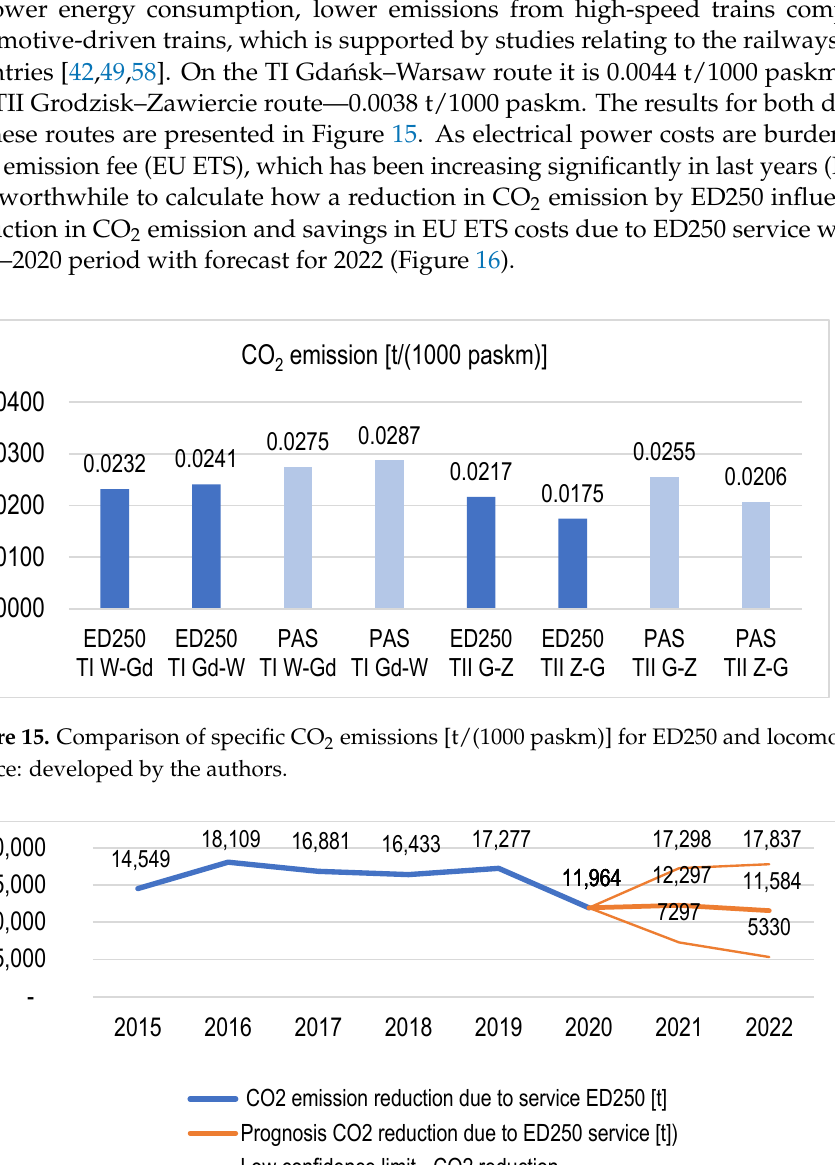
Figure 14. Comparison the specific energy consumption E up per 1000 paskm (assumed 100% and